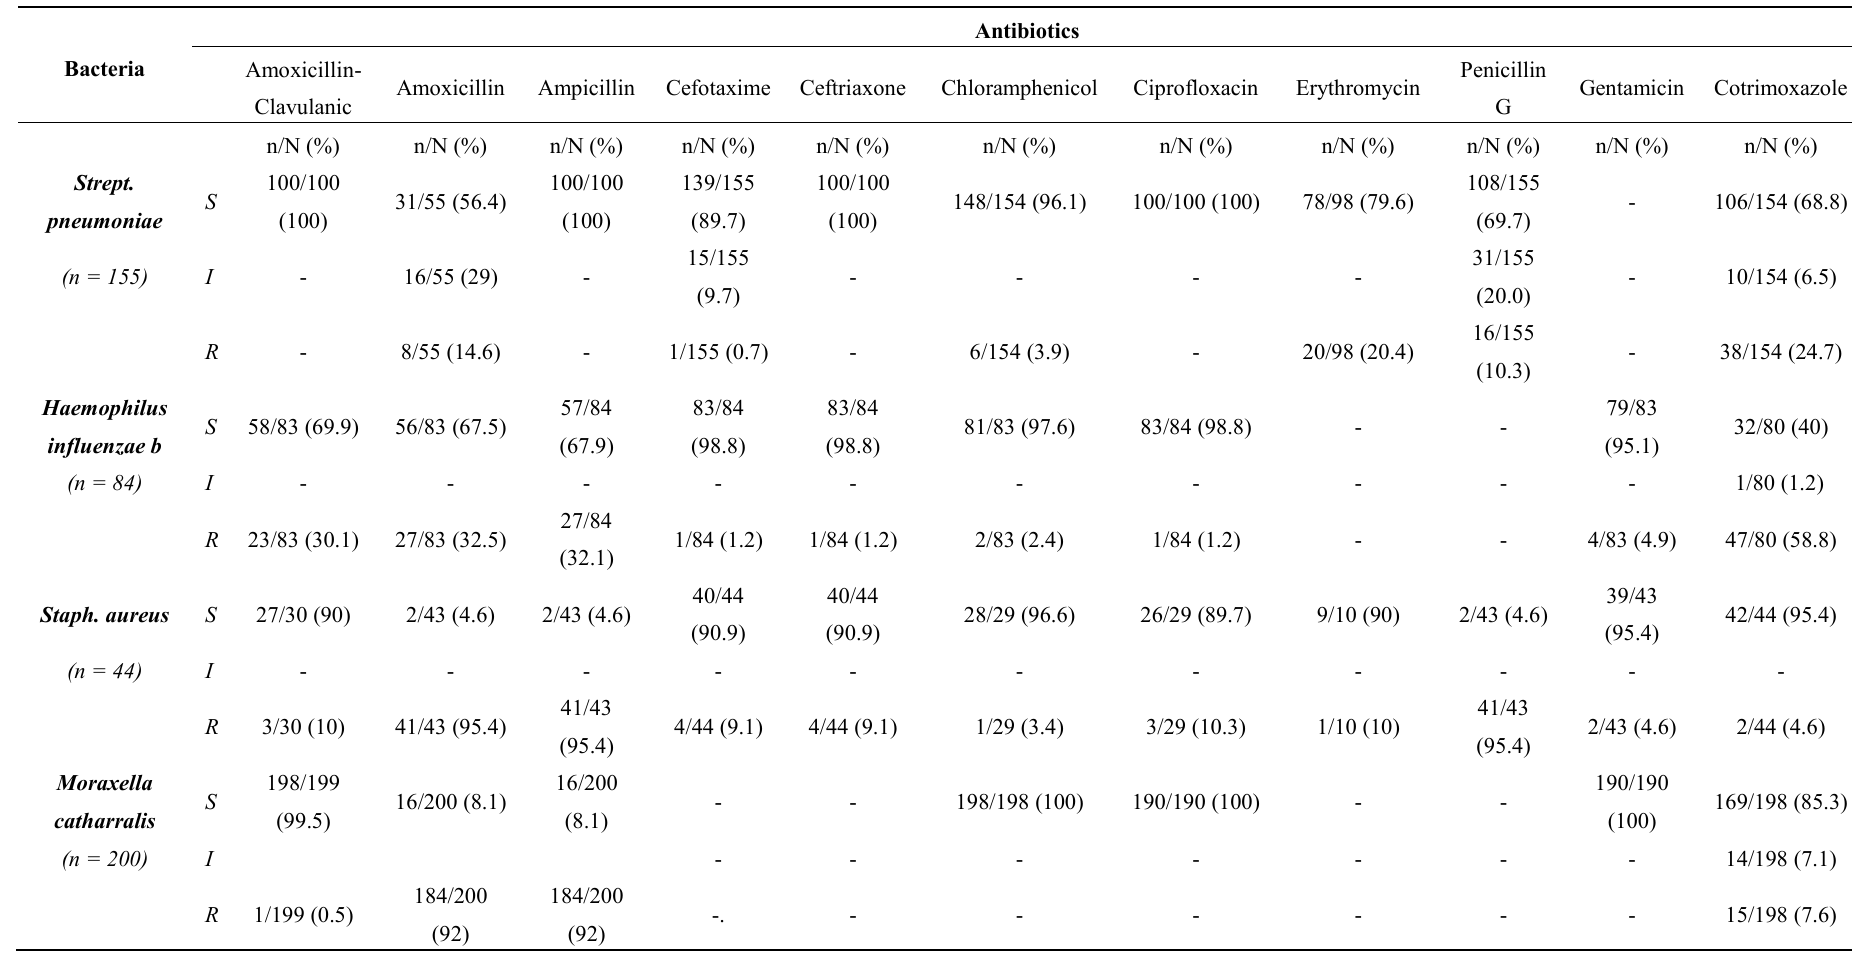
Table 4. Antibiotic susceptibility patterns of respiratory bacteria detected in nasopharynx of hospitalized children with clinical severe